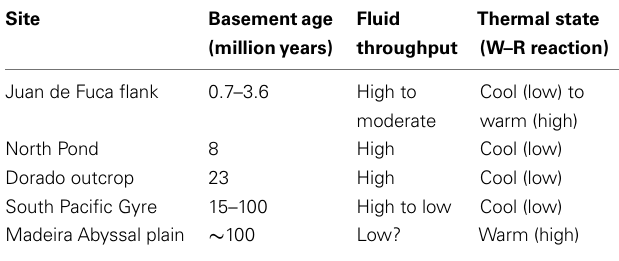
Site characteristics are based on studies cited in the next of the paper. Two hydrothermal regimes are discussed for the eastern flank of the Juan de Fuca Ridge, a younger (cooler) area closer to the active spreading center, and an older (warmer) region farther from the spreading